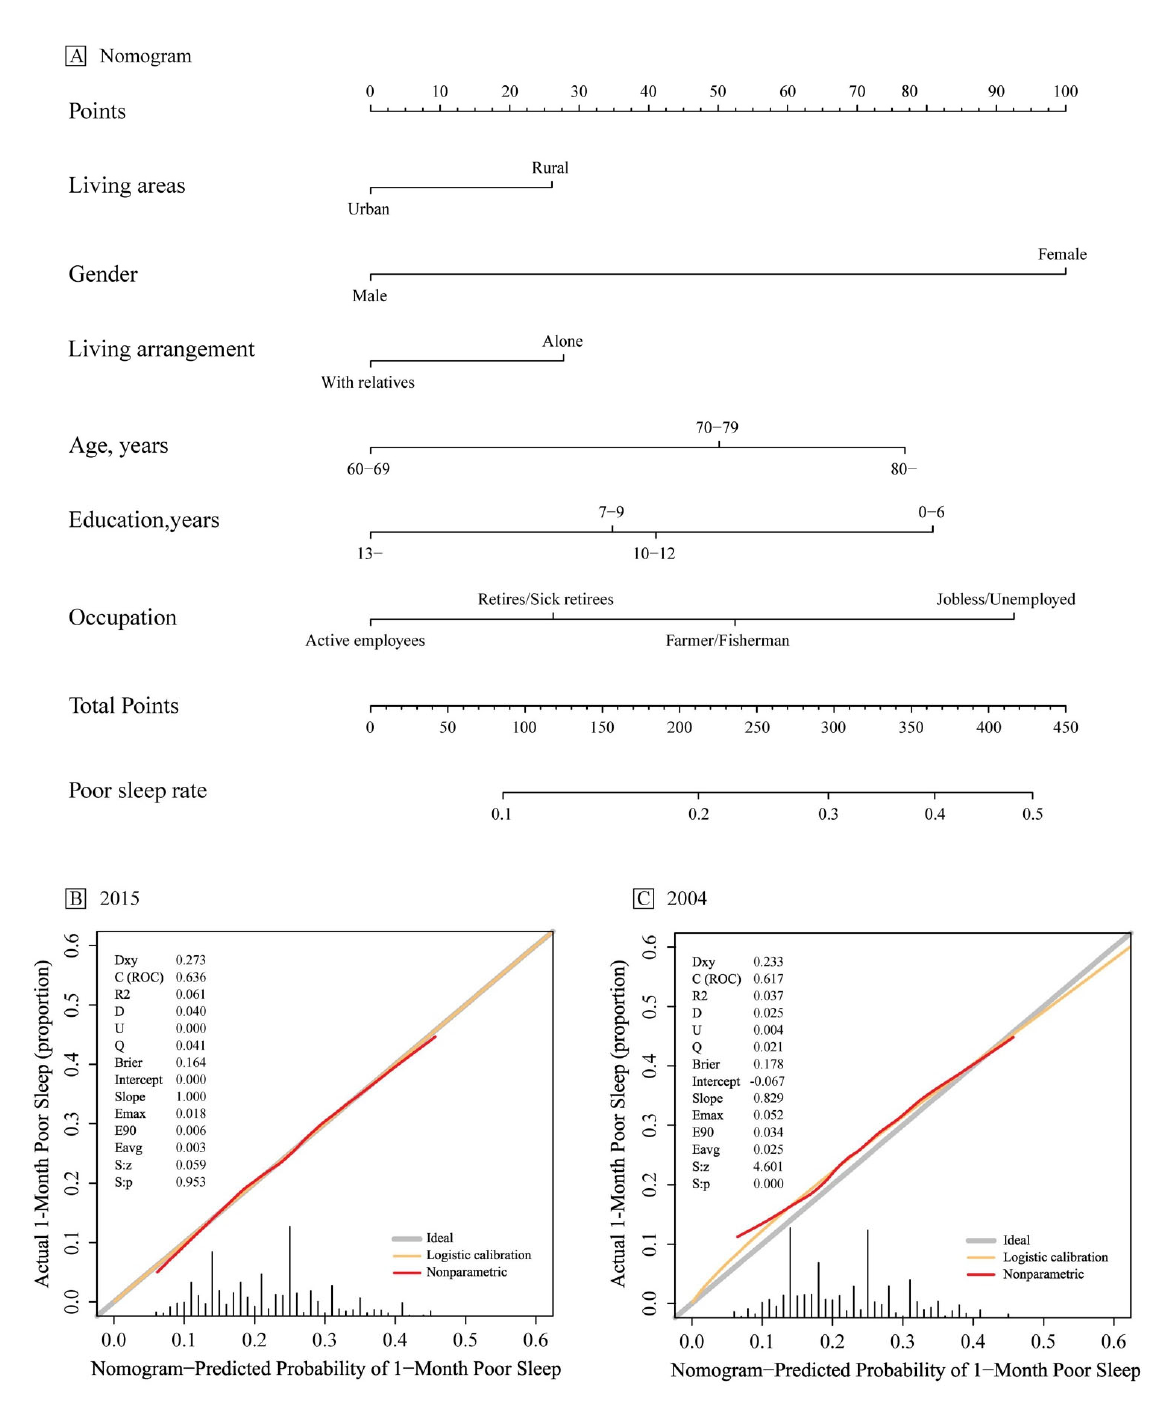
Figure 4. Nomograms for predicting the risk of poor sleep in an elderly population aged ≥ 60 years in Shandong province and its predictive performance. ( A ) Nomogram for estimating the risk of poor sleep in older adults in Shandong province. To use the nomogram, find the position of each variable on the corresponding axis, draw a line to the points’ axis for the number of points, add the points from all of the variables, and draw a line from the total points’ axis to determine the poor sleep probabilities at the lower line of the nomogram. ( B ) Validity of the predictive performance of the nomogram in estimating the risk of poor sleep presence in 2015 ( n = 10,894). ( C ) Validity of the predictive performance of the nomogram in estimating the risk of poor sleep presence in 2004 ( n = 4451). C-index, concordance index; U, calibration degree